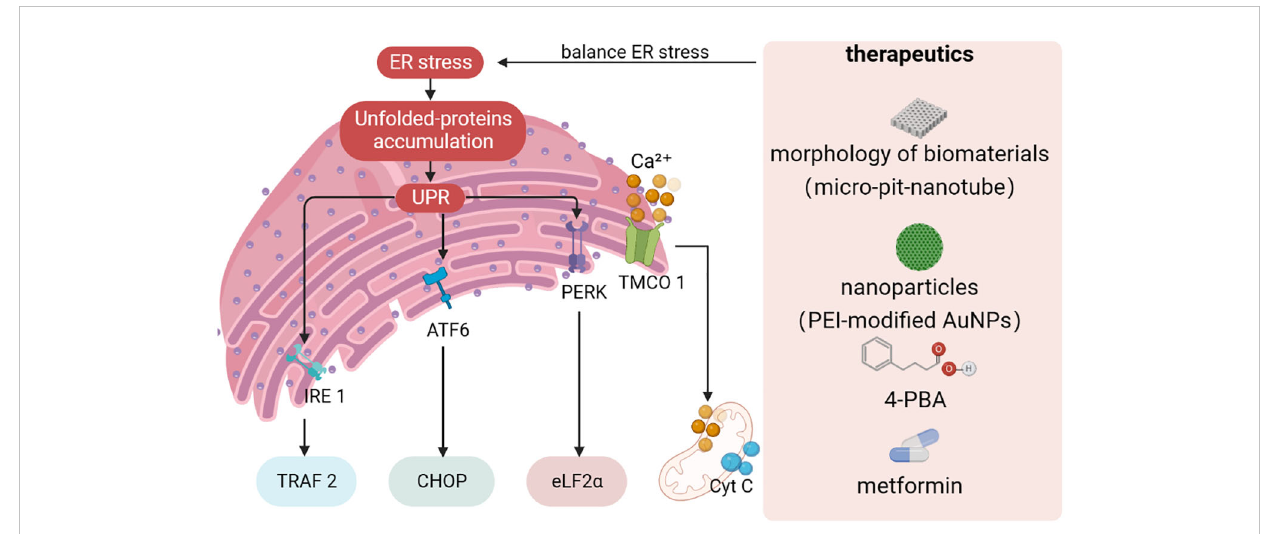
FIGURE 2 Design strategies towards to ER stress. Protein misfolding or unfolding can cause disorders in ER homeostasis, leading to ER stress. If ER stress is not resolved in time, unfolded or misfolded proteins accumulate in the ER, and the UPR triggers a cascade through IRE1 a , ATF6, and PERK signaling pathways. At the same time, fl uctuations in ER and mitochondrial Ca 2+ homeostasis can trigger interactions between organelles. The establishment of therapeutic strategies for ER stress has become an indispensable part of regulating ER homeostasis to promote osteogenic differentiation. UPR, unfolded protein response; TMCO1, transmembrane and helix-coil structural domain 1, 4-PBA: 4-phenylbutiric